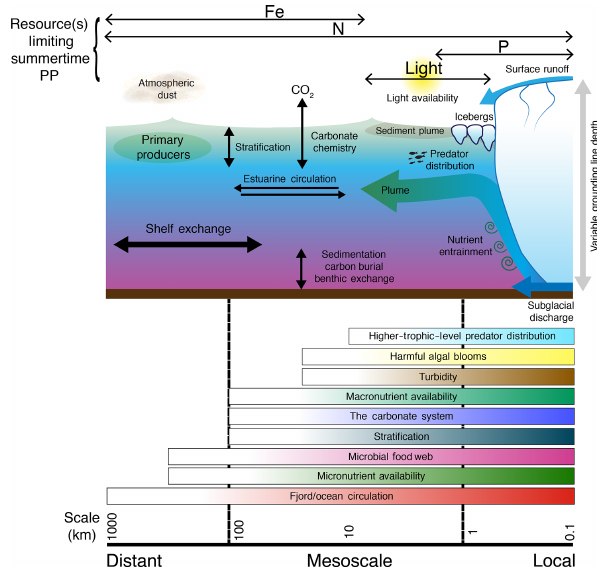
Figure 11. The approximate spatial scale over which glaciers di- rectly affect different drivers of marine primary production (PP) compared to the likely limiting resources constraining primary pro-